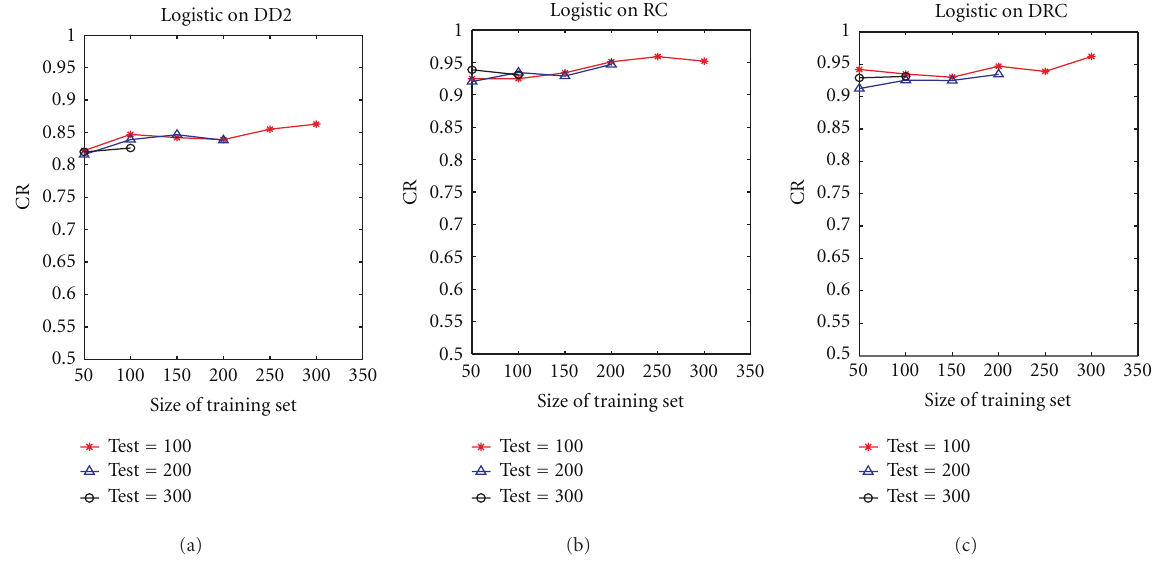
Figure 3: Variation of classification rate (CR) with size of training set using the proposed descriptors DD2 (a), RC (b), and DRC (c). Results are shown for the average over 10 runs, using logistic regression as the